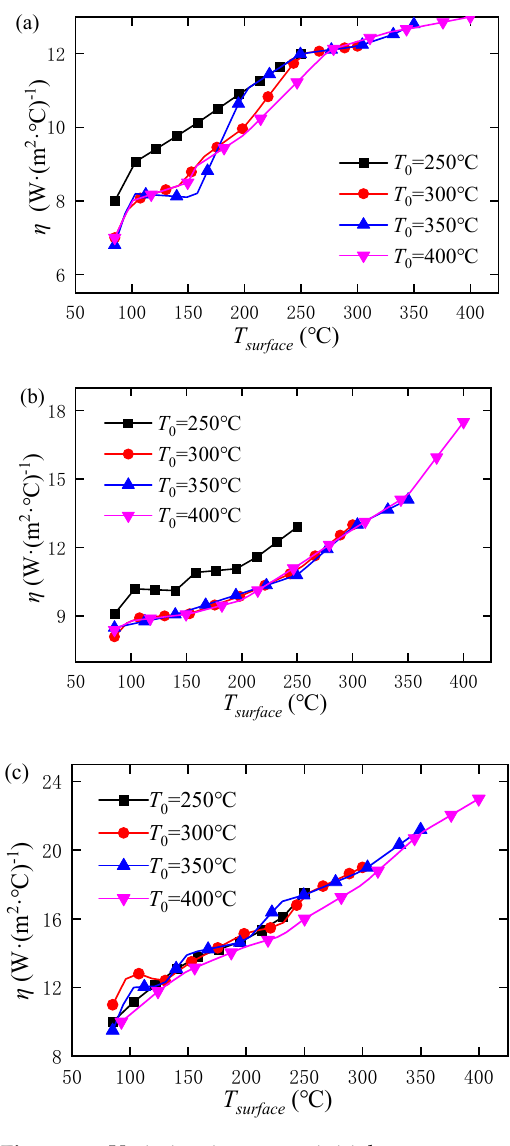
Figure 7. Variation in η over initial temperature and cooling time under different thicknesses. ( a ) 8 mm; ( b ) 15 mm; ( c ) 31